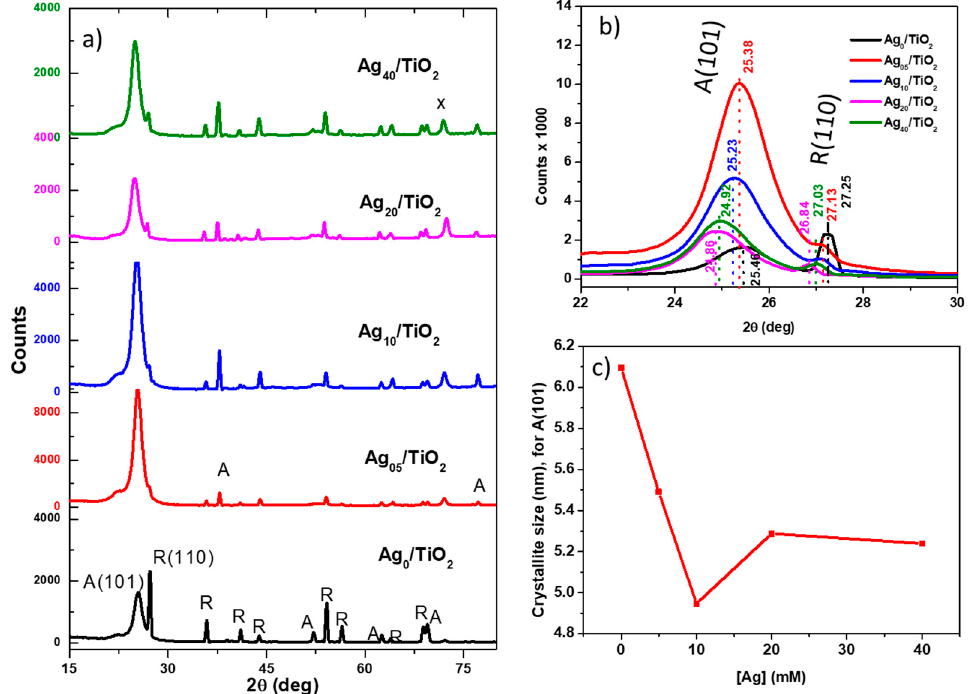
Figure 2. ( a ) XRD patterns of Ag x /TiO 2 samples, ( b ) expanded 2-theta range (22–30°) for A(101) peak, and ( c ) the calculated crystallite size from A(101) corresponding to anatase phase.